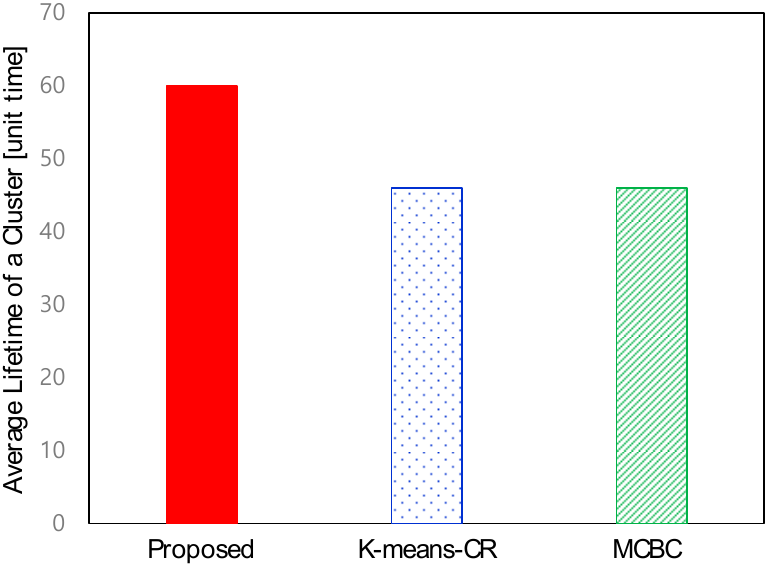
Figure 10. Average lifetime of a cluster.